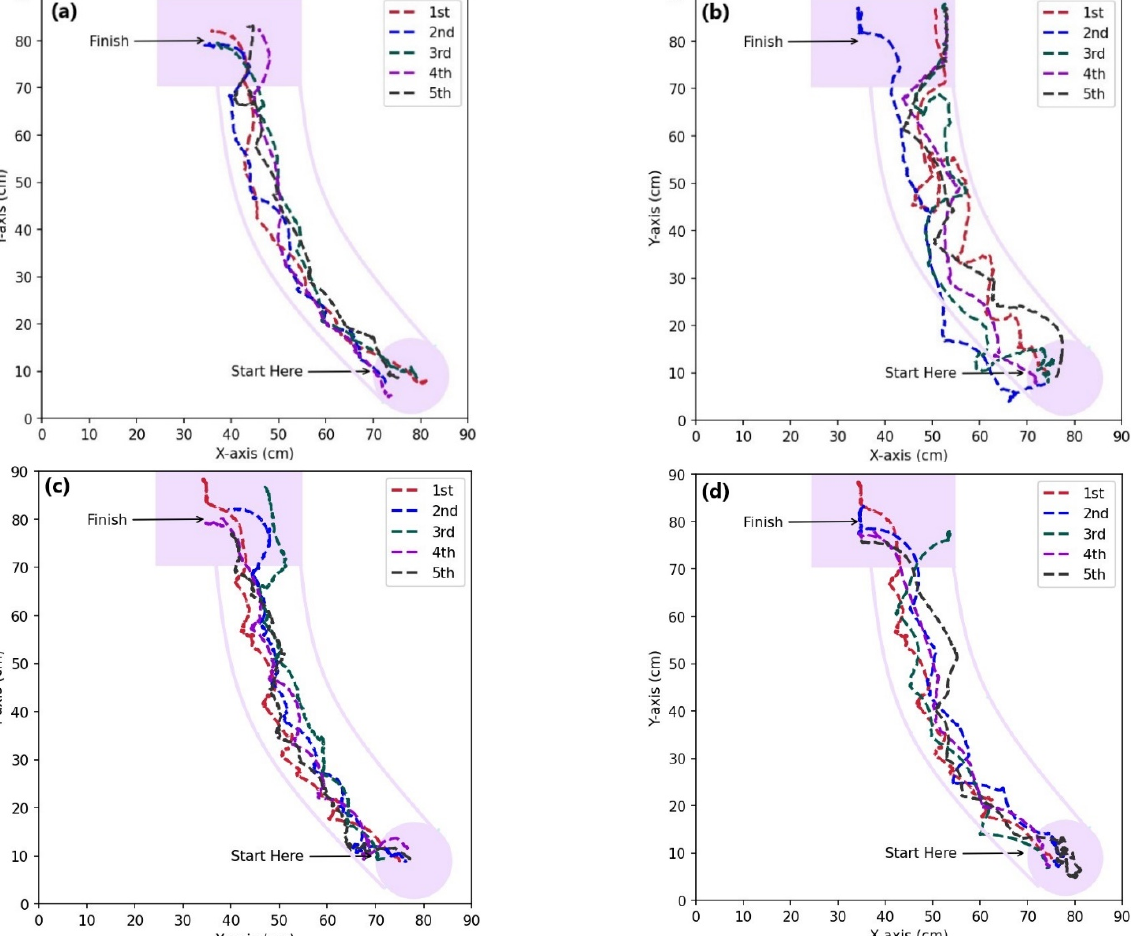
Figure 14. Teleoperated operation of path following without obstacle: ( a ) first cockroach, ( b ) second cockroach, ( c ) fourth cockroach, ( d ) fifth cockroach.